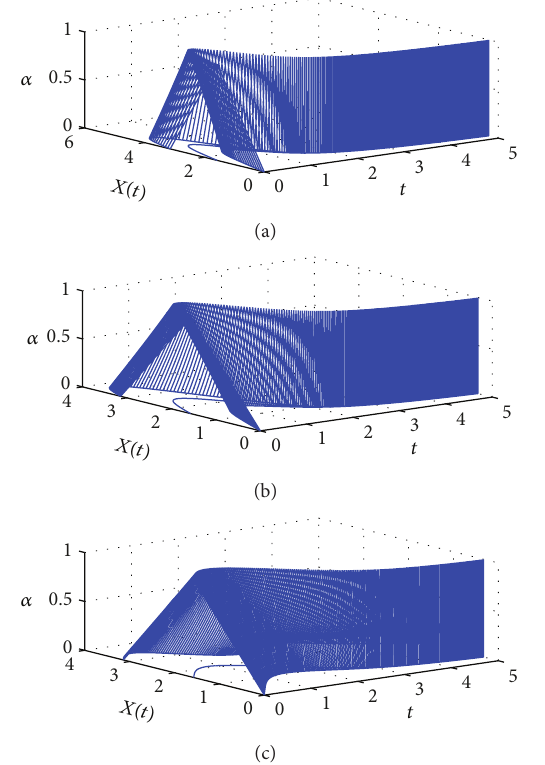
Figure 3: The approximate solutions of (55) for (a) 𝛽 = 0.6 , (b) 𝛽 = 0.8 , and (c) 𝛽 = 1